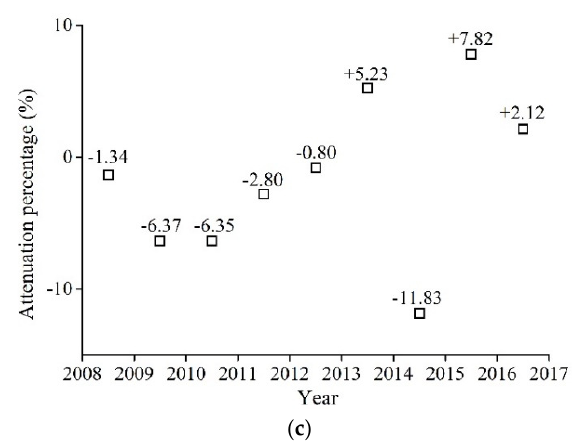
Figure 11. ( a ) TOA radiance in selected grid squares; ( b ) response characteristics of the IRS B08 during its lifetime. ∆ DN is the range of DN when the radiance range was 5.0–8.0 W · m − 2 · sr − 1 · µ m − 1 , calculated according to the radiance calibration equation in this study; ( c ) percent attenuation from 2008 to 2017.